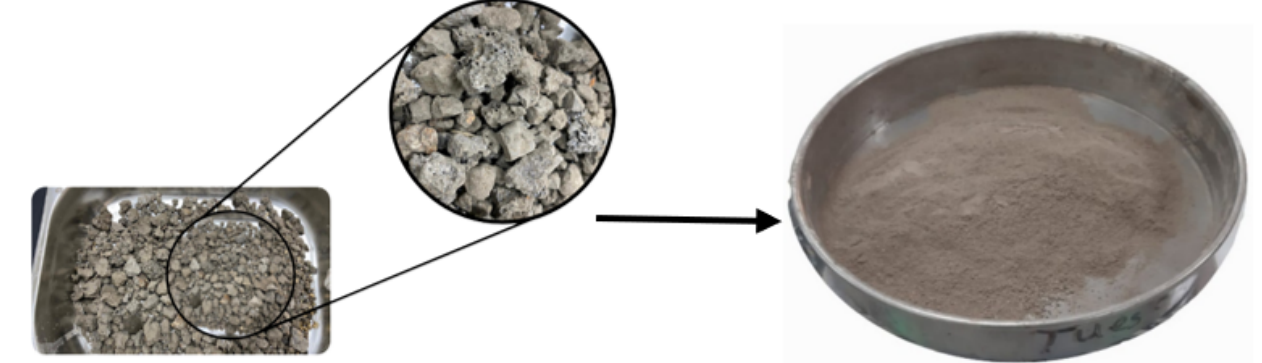
Figure 3. The steel slag material used before and after being crushed.